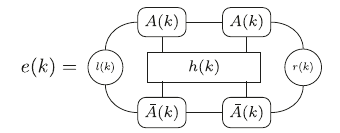
Fig. 1 Computing the energy density in uMPS. Tensor diagram representing the contraction for obtaining energy density in